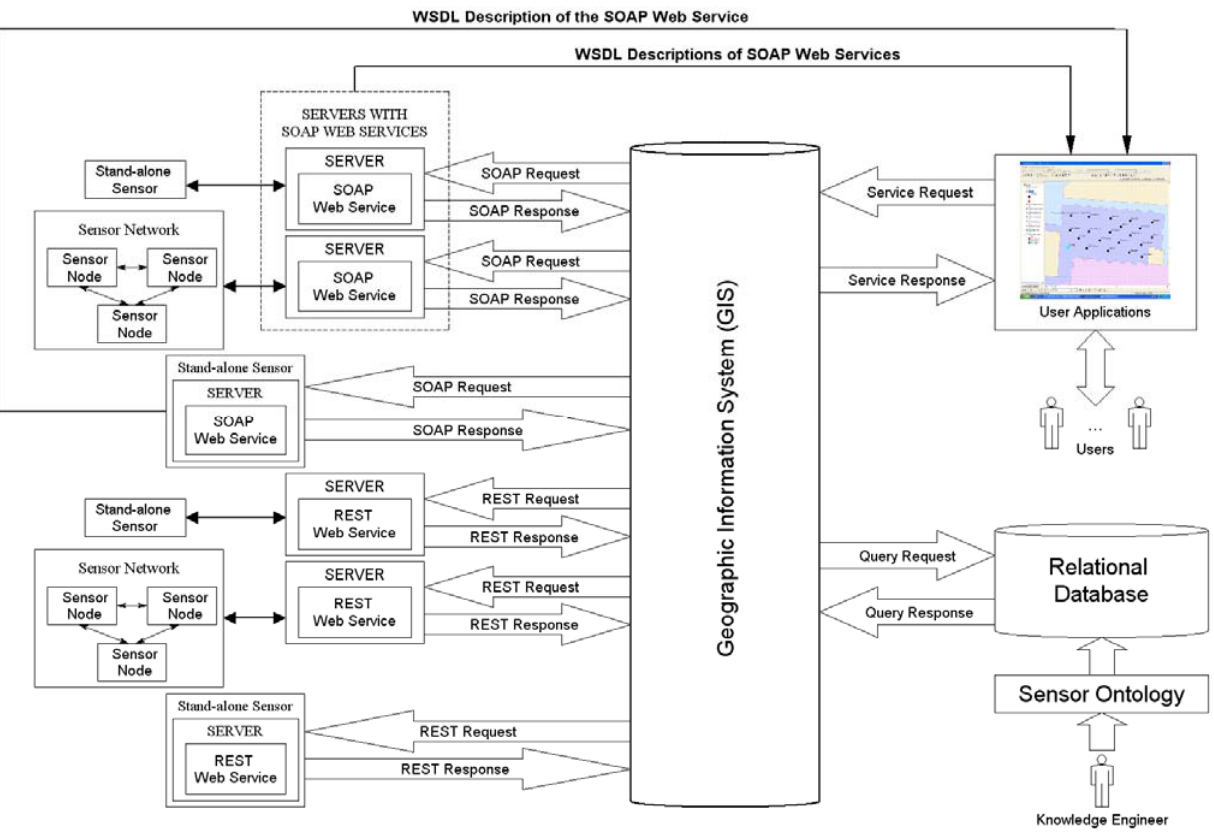
Figure 1. Prototype architecture for coupling sensor deployments with